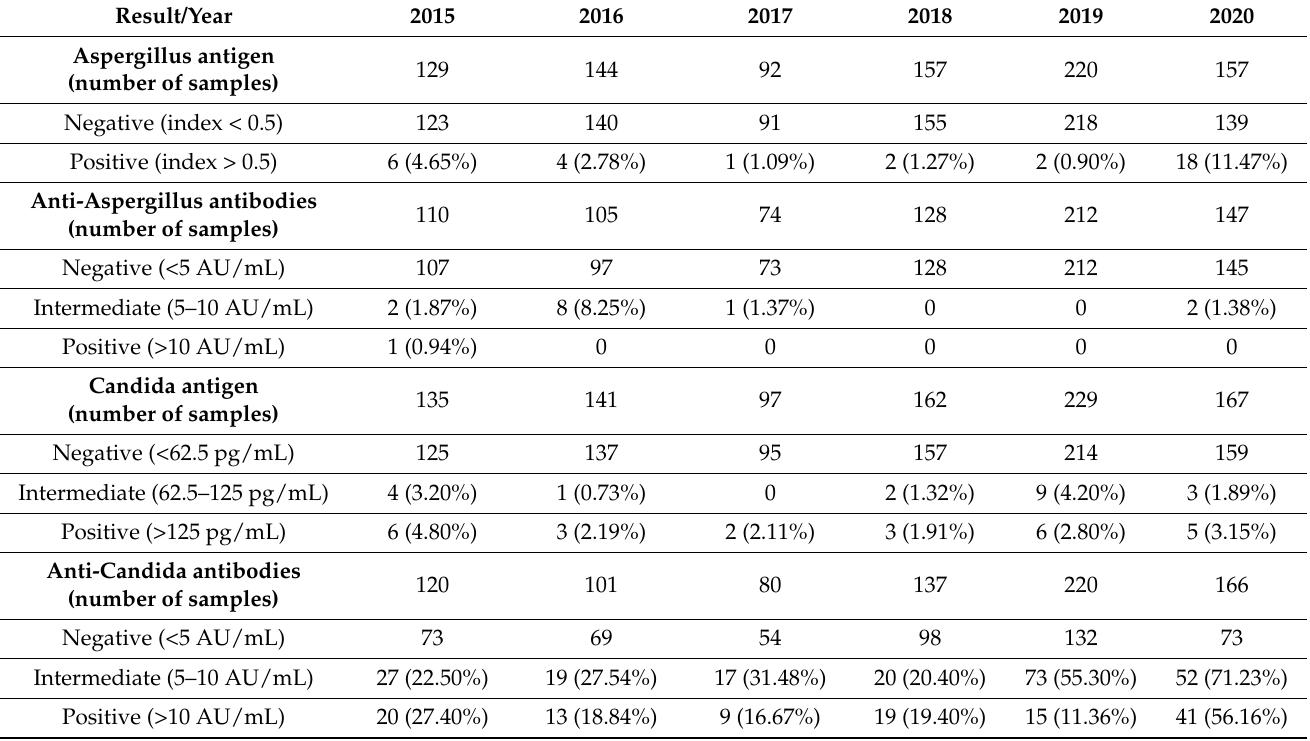
Table 5. Serological test results detailed by